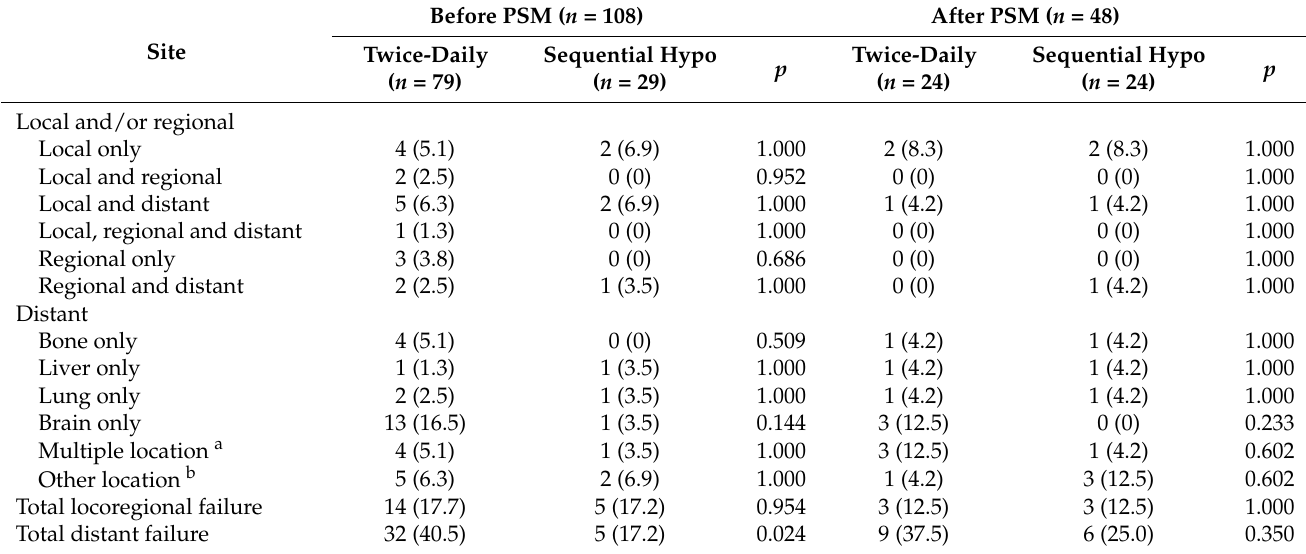
Table 4. Incidence and site of progression or recurrent disease [ n